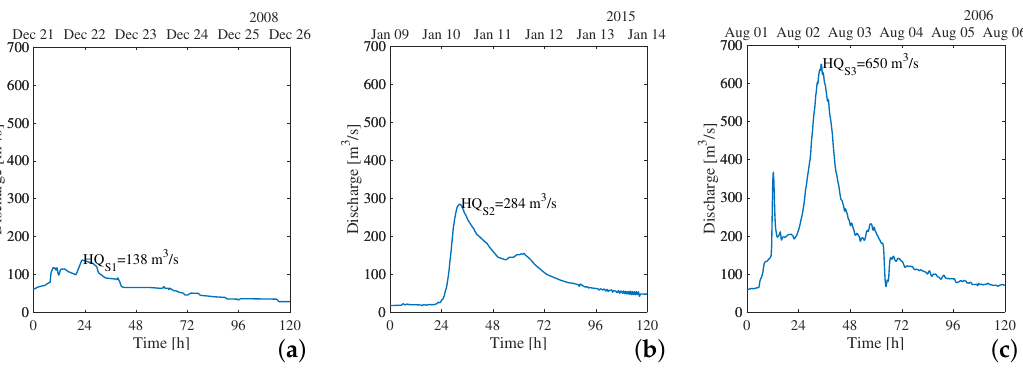
Figure 6. Hydrograph at the inlet boundary: ( a ) normal flow event; ( b ) medium flood event; and ( c ) high flood event.